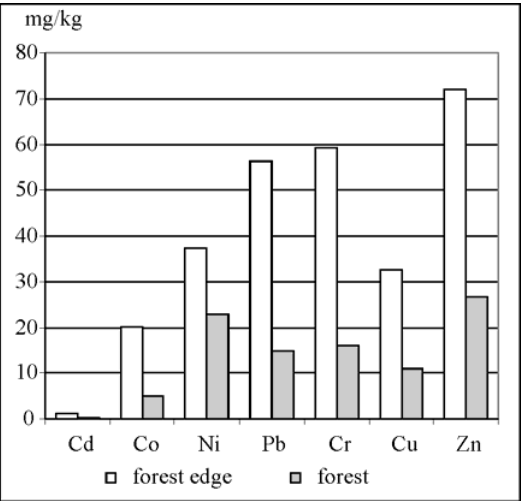
Fig 1. Contents of heavy metals in humus layer